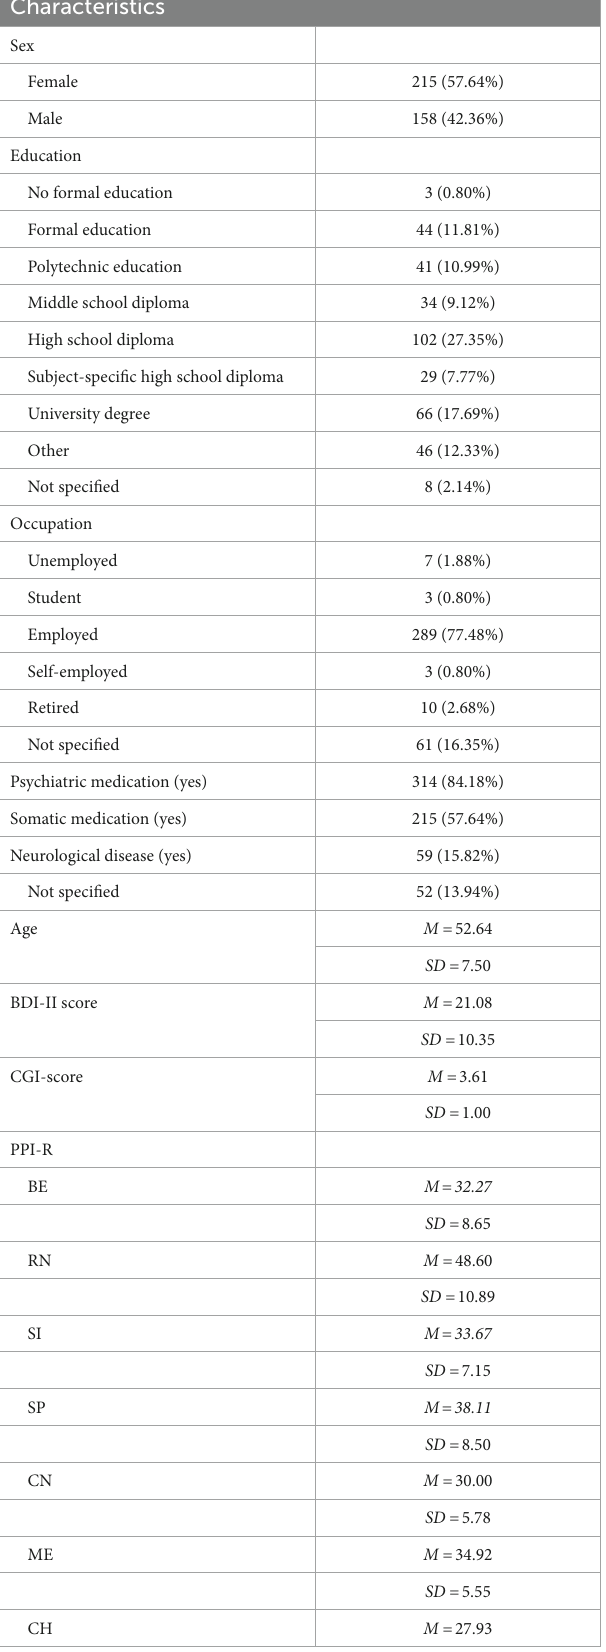
TABLE 2 Socio-demographic, medical, and psychological